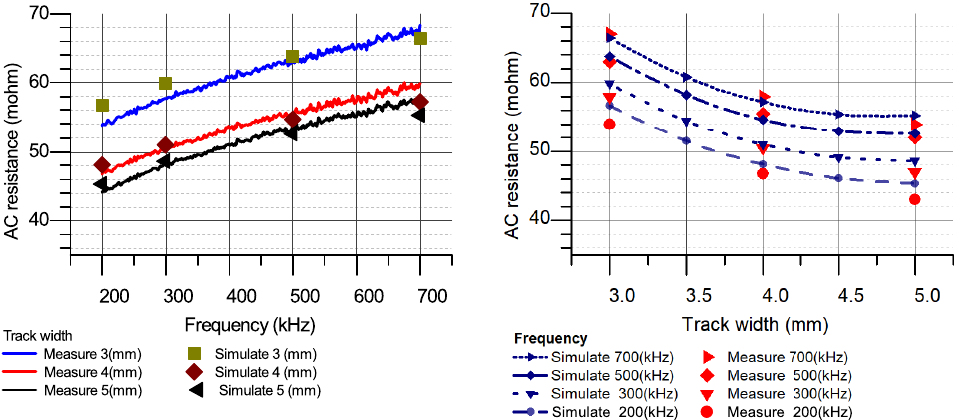
Figure 15. Group-1 measured and simulated AC resistances with changing in frequency ( left ) and track width ( right ).